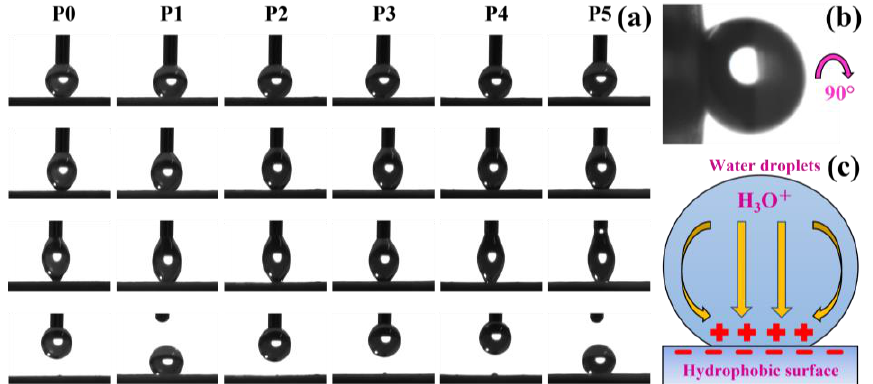
Figure 6. Adhesion on the surface of membranes P0–P5 and its mechanism. ( a ) Different adhesion of membranes P0–P5 to water droplets. ( b ) Water droplets still adhered to the membrane P3 surface even when the membrane was rotated by 90°. ( c ) Electrostatic interaction between the hydrophobic material and the water droplet.